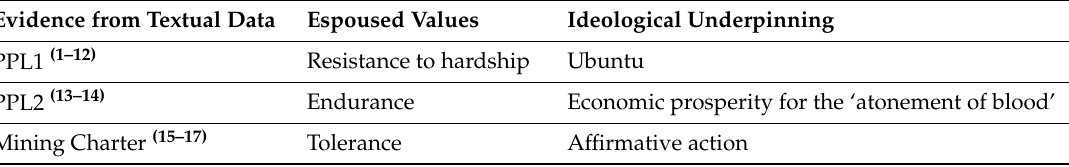
Table 1. Analysis of storylines in the mining